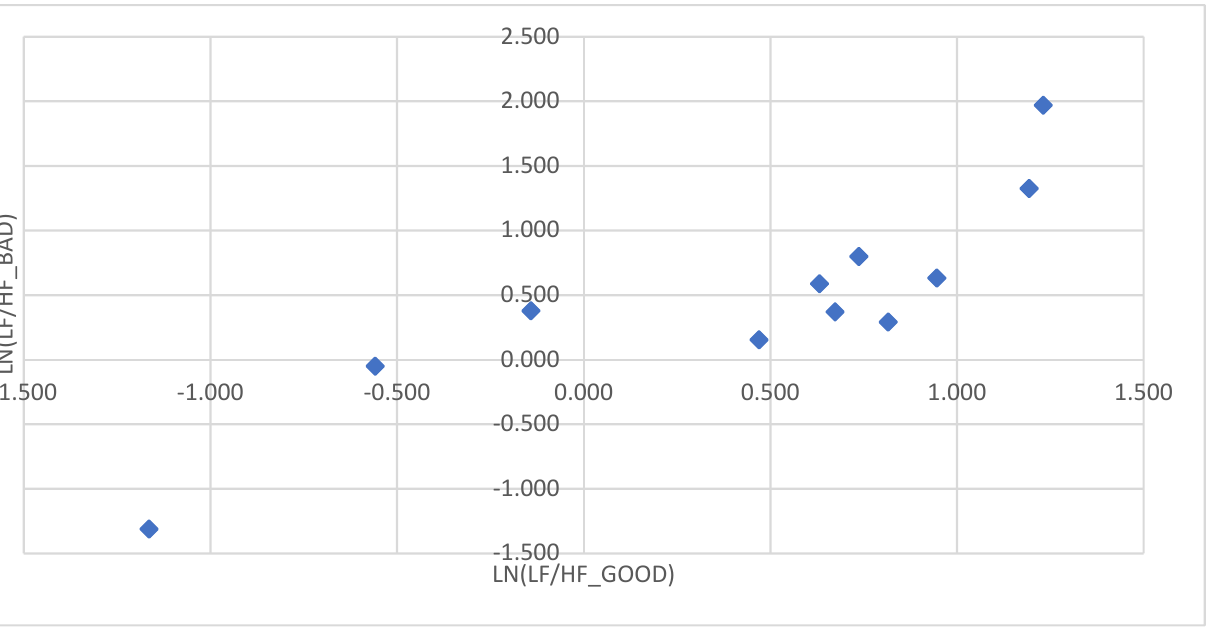
Figure 25. The ratios of the natural logarithms of the mean values of the vegetative balance index in different blocks in the Dissonance Set.